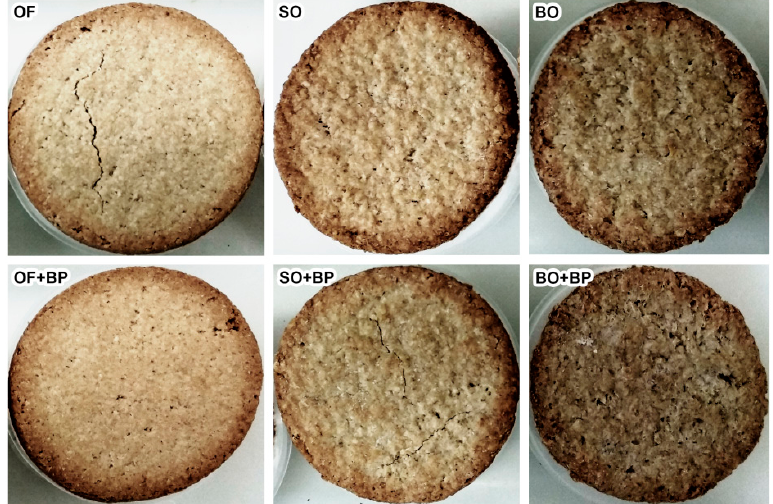
Figure 1. Photograph of the biscuits. OF: oat flour; SO: small oat flakes; BO: big oat flakes; + BP: with baking powder.